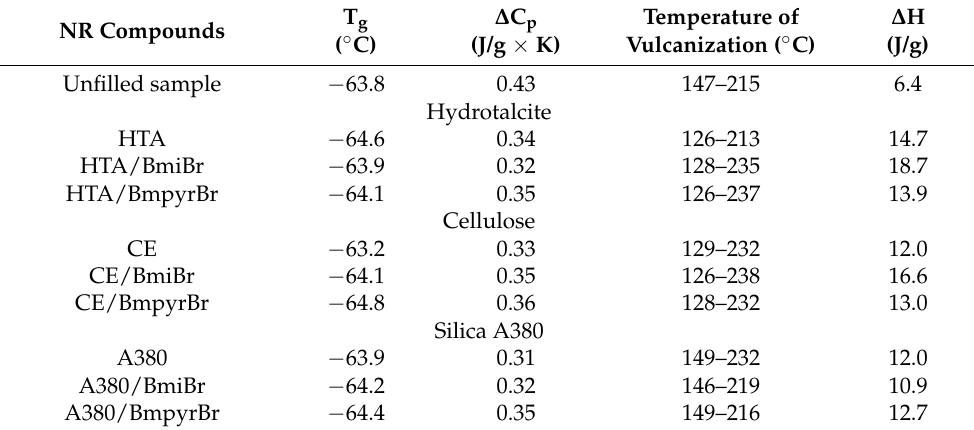
Table 6. Differential scanning calorimetry (DSC) analysis of NR compounds (T g , glass transition temperature; ∆ C p , heat capacity; ∆ H, enthalpy of crosslinking; T g ± 1 ◦ C, ∆ C p ± 0.1 J/g × K, temperature ± 9.0 ◦ C; ∆ H ± 1.2